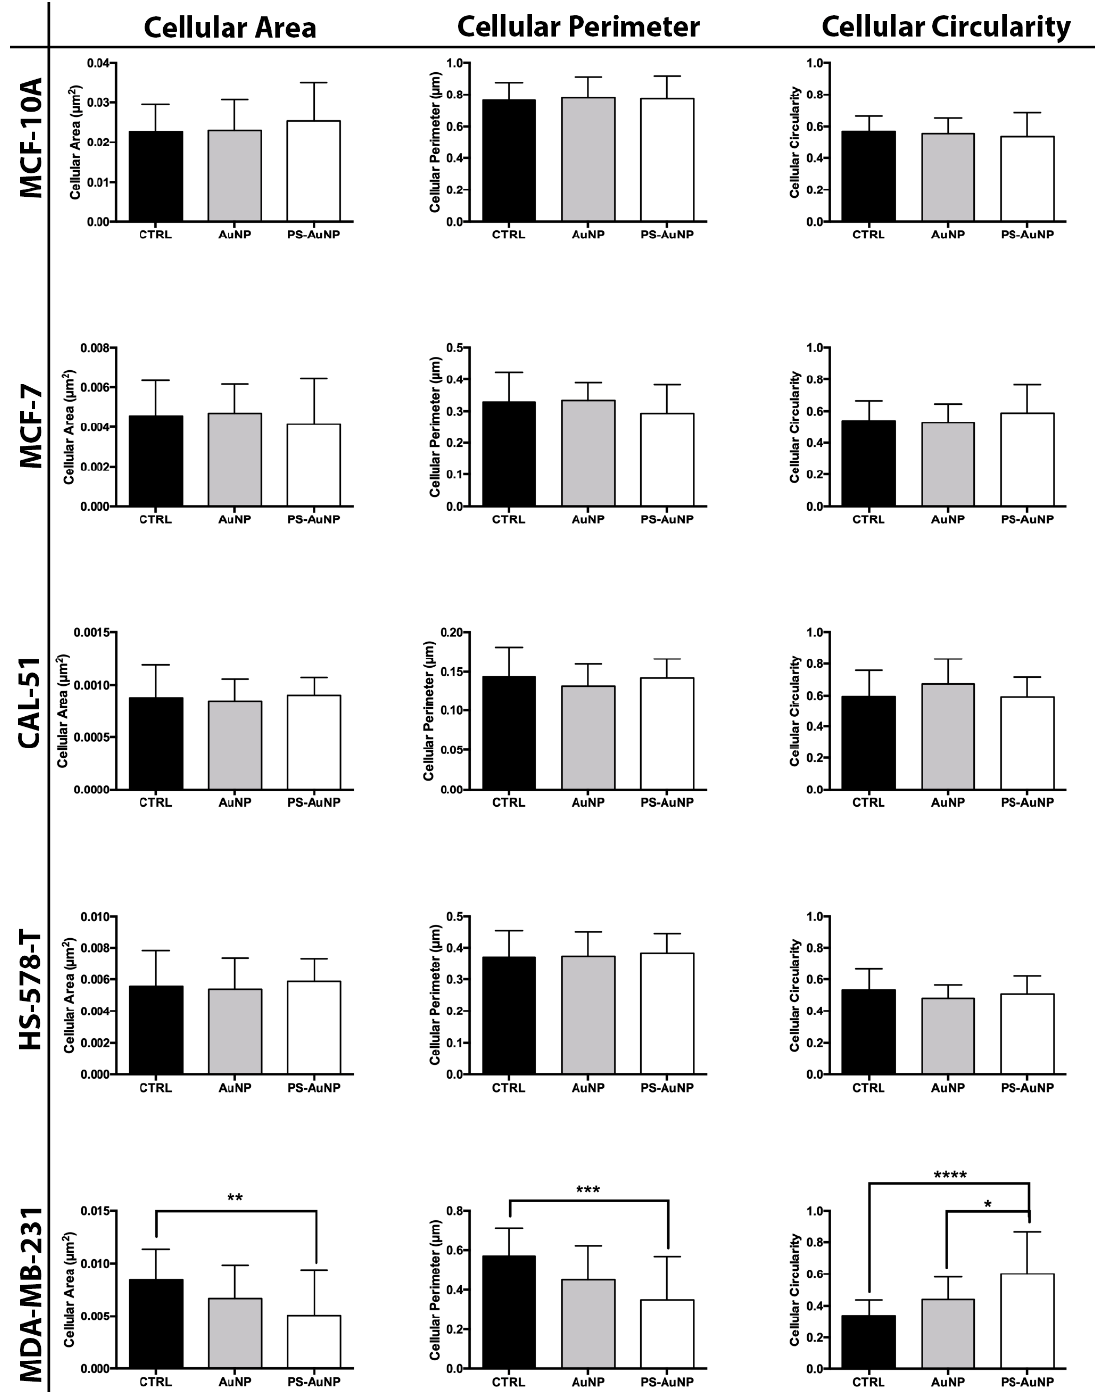
Figure 7. PS-AuNPs induce significant decreases in cellular area and perimeter and significant increases in cell circularity in breast cancer (MDA-MB-231) cells compared to PBS (control) and AuNP-challenged cells, but not in a normal prostate (MCF-10A) cell line. Cellular Area (left), Cellular Perimeter (Center), and Cell Circularity (Right) of MCF-10A normal prostate cell line and the prostate cancer cell lines MCF-7, CAL-51, HS578-T, and MDA-MB-231. * means p < 0.05 between the annotated samples; ** means p < 0.01 between the annotated samples; *** means p < 0.001 between the annotated samples; and **** means p < 0.0001 between the annotated samples.